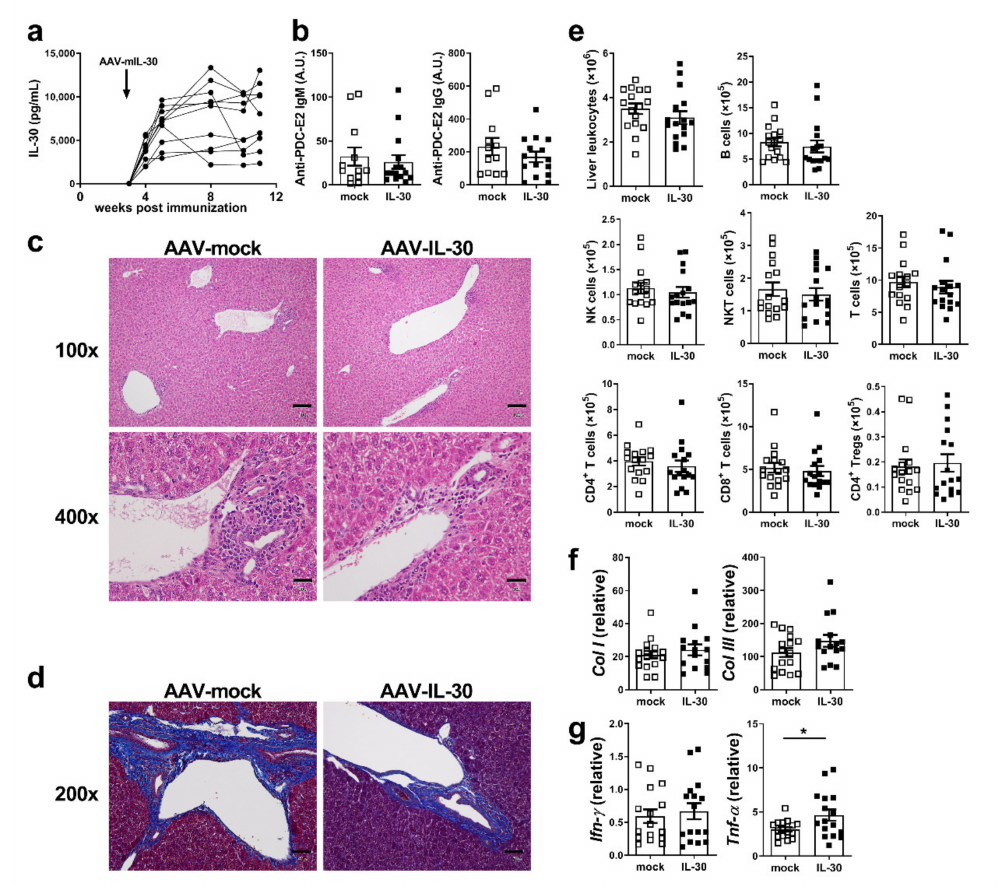
Figure 5. Administration of AAV-mIL-30 did not alleviate the disease. Mice were injected with AAV-mIL-30 or AAV-mock at 3 weeks after the first 2-OA-OVA immunization and sacrificed at Week 11. ( a ) Serum levels of IL-30 in AAV-mIL-30-injected mice. IL-30 was undetectable in mice treated with AAV-mock. ( b ) Serum levels of anti-PDC-E2 IgM and IgG were measured using ELISA. A.U. arbitrary unit. ( c , d ) Representative pictures of liver tissue stained with ( c ) hematoxylin and eosin (H&E) (scale bar, 100 × , 100 µ m; 400 × , 300 µ m) and ( d ) Masson’s trichrome (scale bar, 50 µ m). ( e ) Liver cell infiltrates were counted. ( f ) The expression of collagen I and collagen III mRNA in the liver was detected using RT-qPCR. ( g ) Liver IFN- γ and TNF- α mRNA expression was detected using RT-qPCR. Relative quantification was performed by 2 − ∆ CT method and multiplied by 10,000. Each dot represents an individual mouse. n = 15–17 mice per group. All error bars denote ± SEM. *, p < 0.05.